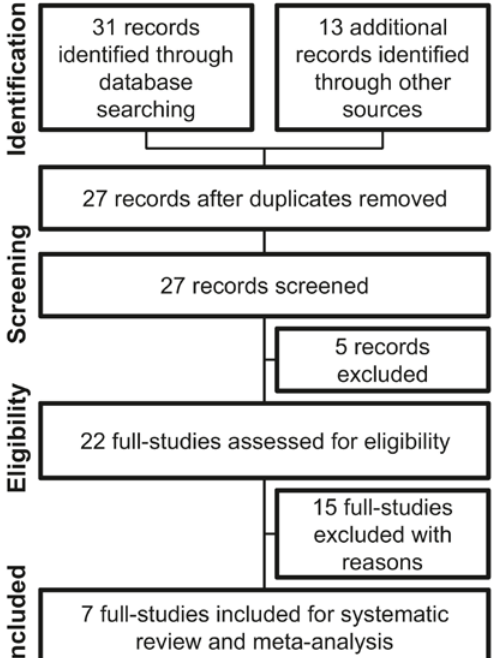
Figure 1. Preferred Reporting Items for Systematic Reviews and Meta-Analyses (PRISMA) flow information diagram used to select studies on the effects of polydextrose on subjective feelings of appetite for this review.